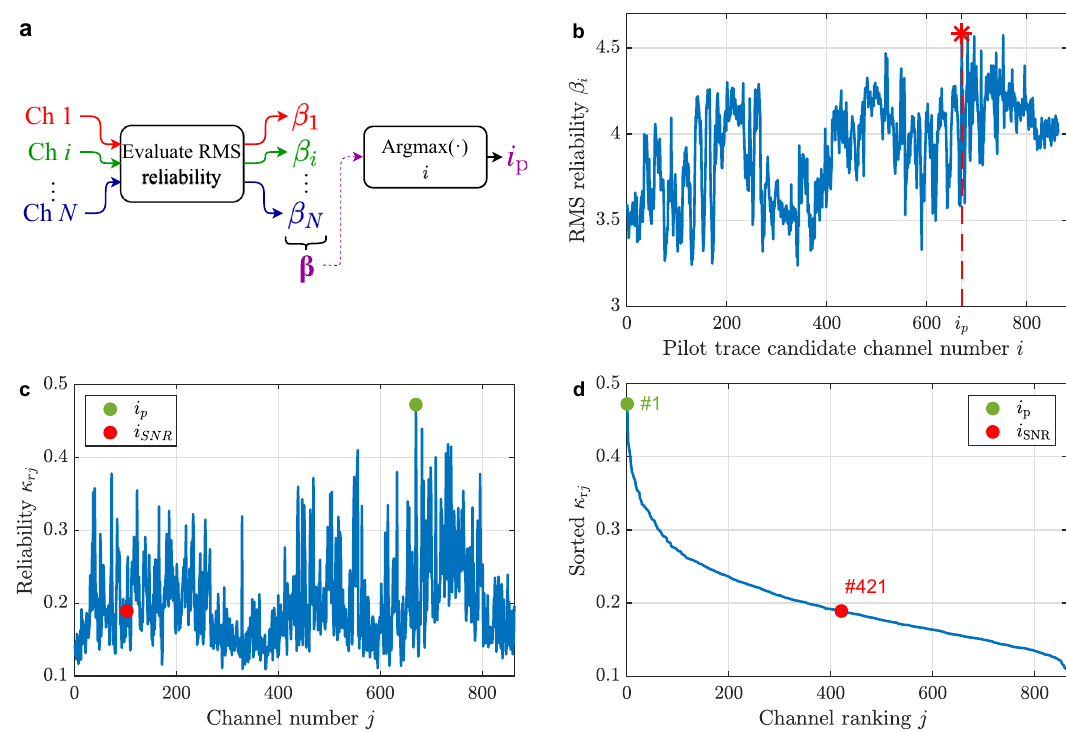
Fig. 2 Blind pilot trace selection from data. a The scheme shows the procedure utilised to fi nd the most reliable channel as a pilot trace. In the process, each acoustic channel i is considered as a pilot trace candidate and is compared with all the other DAS channels j , with j = 1, … , N , where N is the total number of longitudinal acoustic channels. The comparison is made by calculating the phase cross-correlation function PCCF ij between the pair of channels ð i ; j Þ and characterising the sharpness of the correlation peak using the indicator κ fi ned in the “ Methods ” . In this way, a 1 xN vector de fi ned as ij de κ ¼ ½ κ ; κ ;:::; κ (cid:2) is obtained for the i th candidate. To blindly estimate the reliability of each candidate pilot trace i , the root-mean-square (RMS) value of i i ; 1 i ; 2 i ; N ; β ; ¼ ; β (cid:2) , which contains the indicators the κ i vector is calculated and de fi ned as β i . Repeating this process for i = 1, … , N , we obtain a 1 xN vector β ¼ ½ β N 1 2 for all the pilot trace candidates. The pilot trace channel i p is then chosen based on the channel having the highest β i value, since it represents the acoustic channel with the highest RMS reliability. b Blind evaluation of the RMS reliability indicator β i for all channels. c Non-blind validation of the method, showing the reliability indicator κ r j for all channels j compared to the known emitted acoustic signal r (reference waveform). The reliability obtained by the proposed method (green circle) is compared to the one based on the use of the channel with the best signal-to-noise ratio (SNR) (red circle). d Reliability ranking obtained by sorting the indicator κ r j . The 1 st position in the ranking represents the channel with the highest κ r j , and therefore, it is the channel with the highest similarity and phase coherence with respect to the reference signal r, while the channel at the 863 rd position corresponds to the channel with the worst κ r j